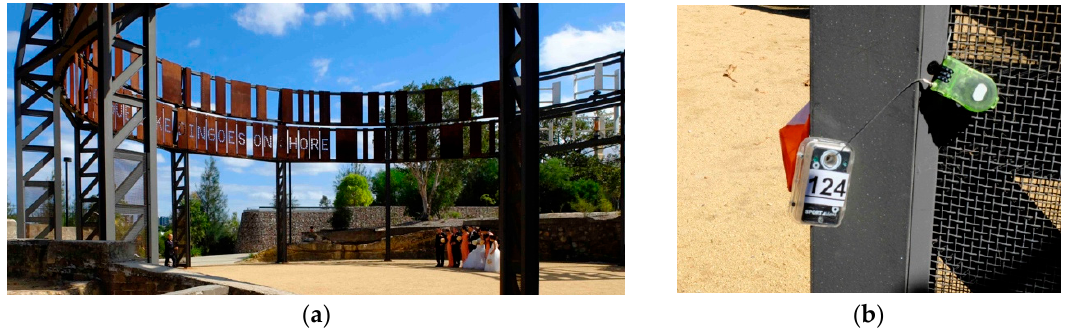
Figure 5. ( a ) The interpretive signage of renewable energy sculpture; ( b ) The renewable energy sculpture. Images by the author.